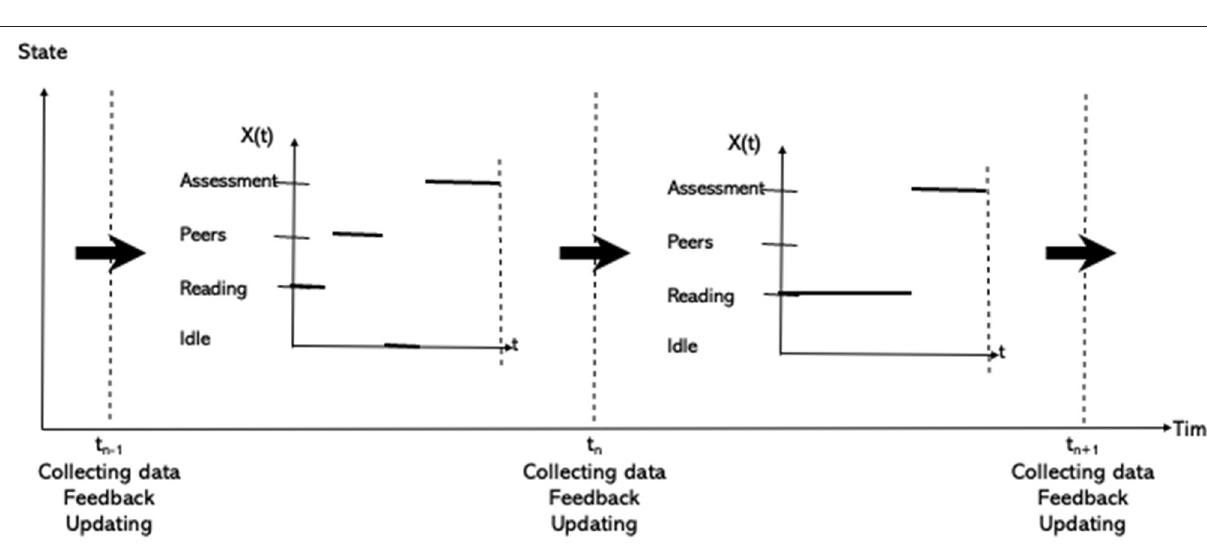
Dotted line probability